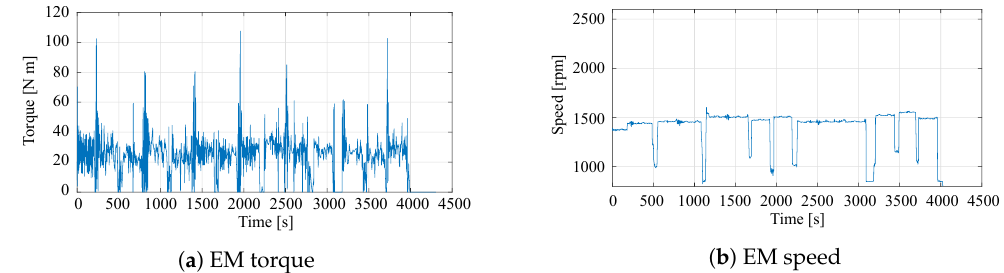
Figure 5. Performance requirements for the Electric Machine (EM) when the tractor is operated in pure electric mode with a plant lifting plough instrument. The numerical data are available in [25].